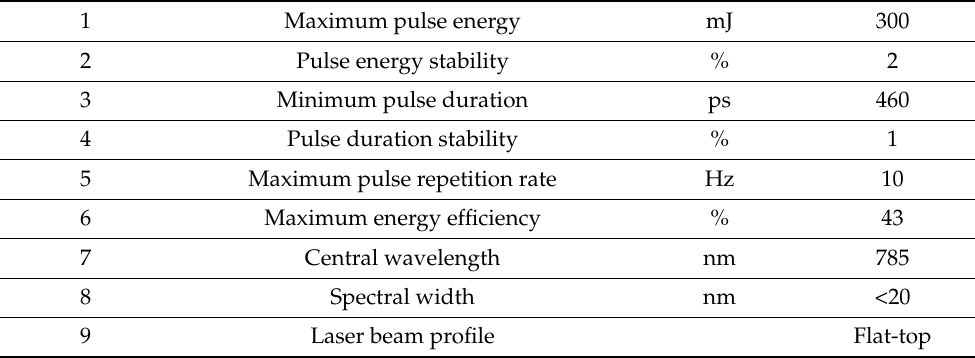
Table 2. Characteristics of Ti:Sapphire laser generation. Reprinted with permission from ref. [17]. Copyright 2019 © The Optical